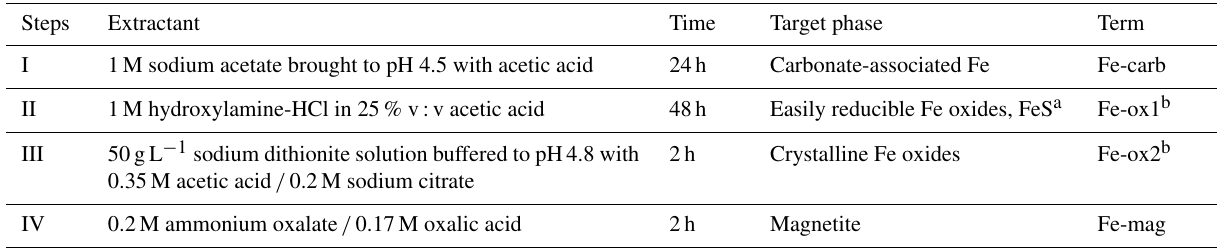
Table 1. Details on the Fe extraction method by Poulton and Canfield (2005): chemical solutions and targeted phases. Steps Extractant Time Target phase